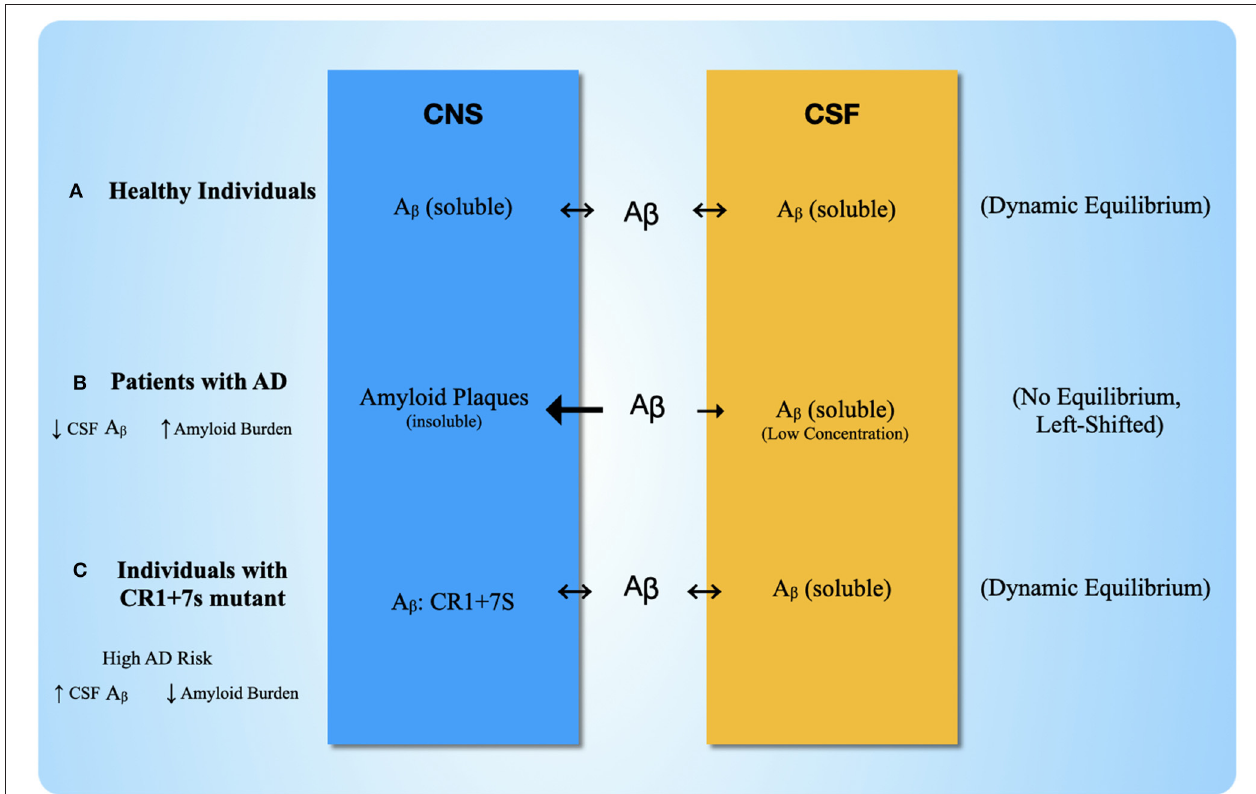
FIGURE 6 | Plausible Explanation for Anomalous Clinical Data with CR1 with seven Sushi Duplication Chemical equilibrium for A β in three different scenarios. (A) In Scenario one, healthy individuals show a balanced chemical equilibrium, where A β moves into both the CNS extracellular space and the CSF at equal rates and remains soluble. (B) Scenario two shows the disruptions that occur to the equilibrium in AD patients. The A β in the CNS becomes insoluble in amyloid plaques, which shifts the equilibrium in favor of plaque formation in the CNS. The result is reduced levels of A β in the CSF. (C) Scenario three shows the equilibrium for individuals with the CR1 + 7s mutant. A β is able to bind CR1 + 7S, which serves as a depot for A β accumulation in the CNS but does not result in plaque formation, allowing continued equilibrium of A β into the CSF. Therefore, for those with the CR1 + 7S mutant, A β levels in the CSF will appear “normal,” but there is still an increased risk for neurodegeneration via the extra C3b binding